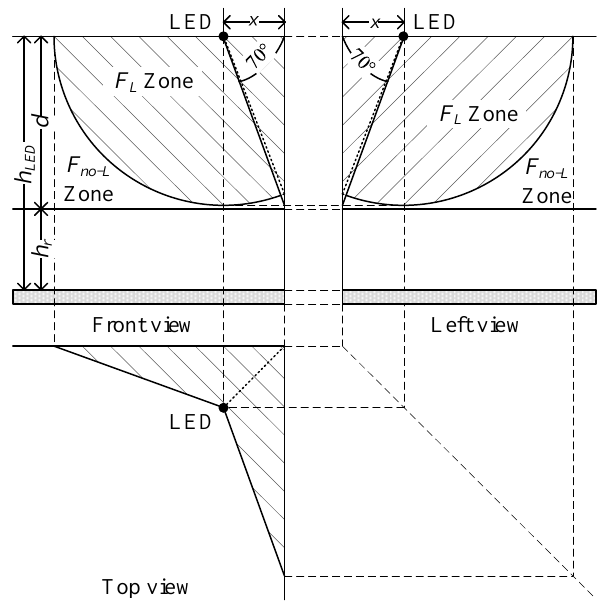
Figure 6. Schematic diagram of the calculation analysis of a corner between two infinitely long walls.